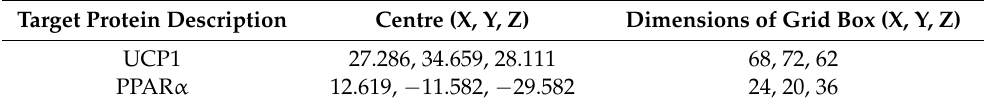
Table 2. Gridbox coordinates of the molecular docking